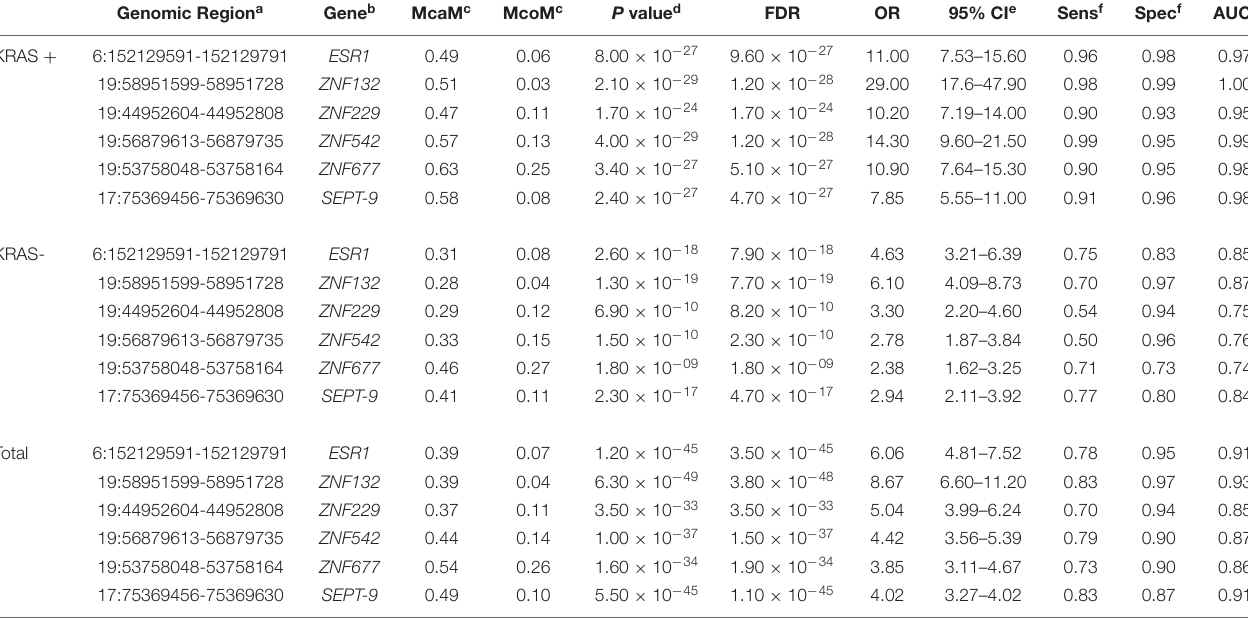
TABLE 2 | The mean methylation status of the five genomic regions in the KRAS + and KRAS- samples of replication cohort 1 and cohort 2. Genomic Region